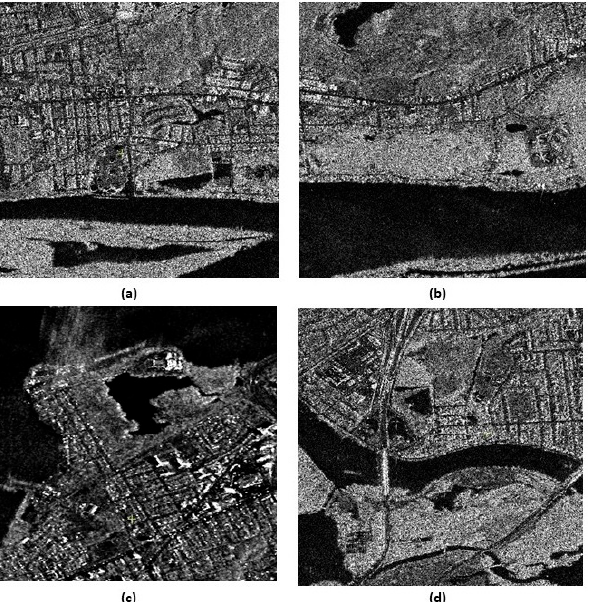
Figure 7. InSAR Coherence images derived from the co-flood TerraSAR-X image over ( a ) Area1, ( b ) Area2, ( c ) Area3, and ( d ) Area4.